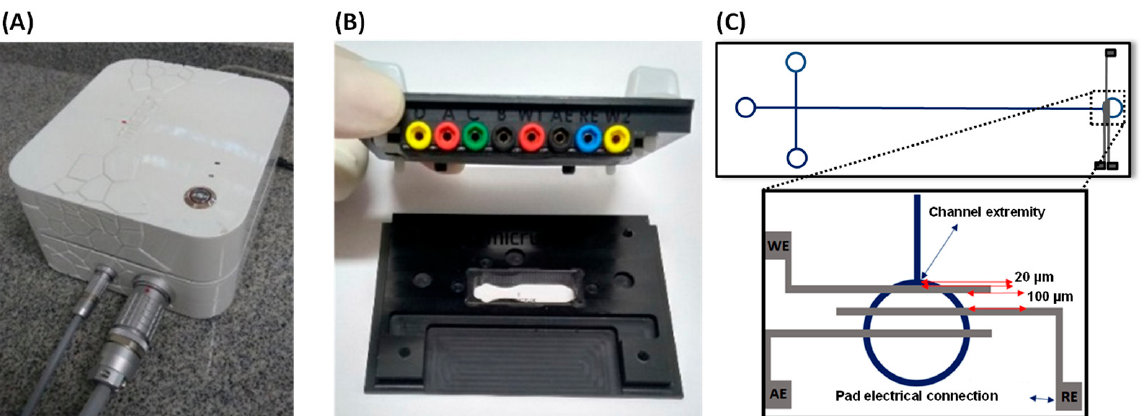
Figure 1. Portable instrumentation for ME–AD analysis including: ( A ) HVStat system manufactured by MicruX Technologies (Asturias, Spain) with integrated bipotentiostat coupled with a high voltage power source, ( B ) microfluidic holder (model MCE-HOLDER-DC02), ( C ) layout of the hybrid mi- crochip composed of SU-8/glass with integrated electrodes for electrochemical detection highlighting the positioning of electrodes at end-channel